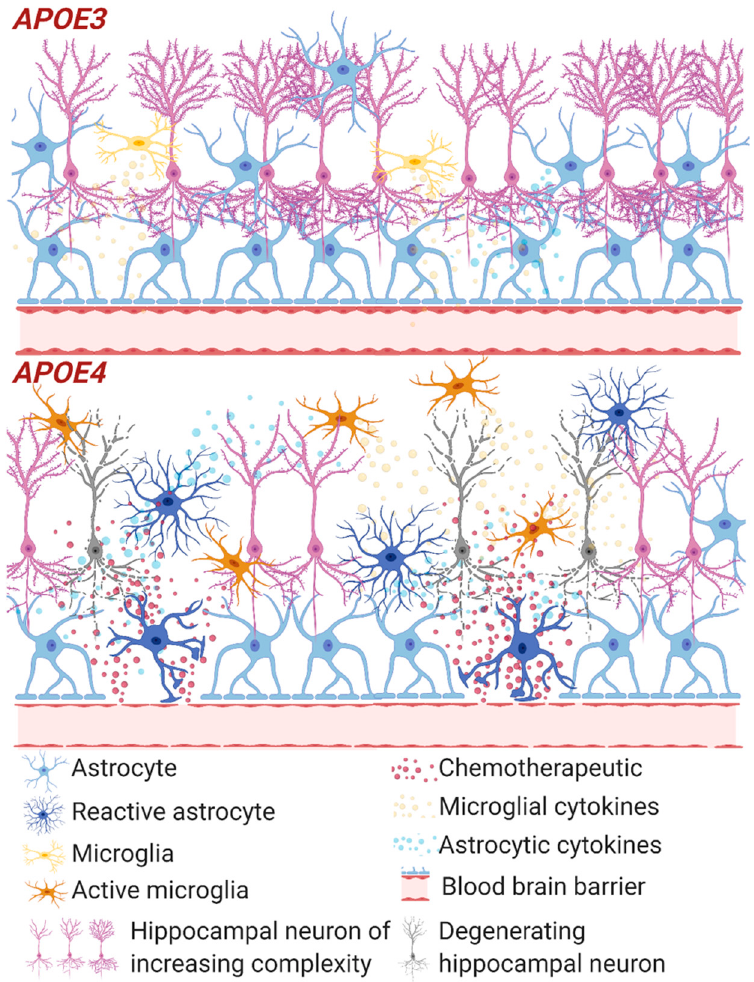
Figure 1. Inflammation and the blood brain barrier with chemotherapy. Summary of impacts of chemotherapeutics on APOE3 and APOE4 neural tissue and the blood brain barrier (BBB). APOE4 show thinning basement membrane and impaired tight junctions leading to increased BBB permeability and release of chemotherapeutic (red particles) into the brain compartment, not apparent in APOE3 . This impairment leads to increasing the already heightened immune and oxidative stress response in APOE4 , increasing reactive astrocytes and active microglia, further increasing BBB breakdown. Ultimately this results in an environment that increases neurodegeneration (grey neurons). Although chemotherapeutic agents are unable to cross the secure APOE3 BBB, they are still able to induce a cytokine response close to the BBB which may damage the integrity of the tight junctions.